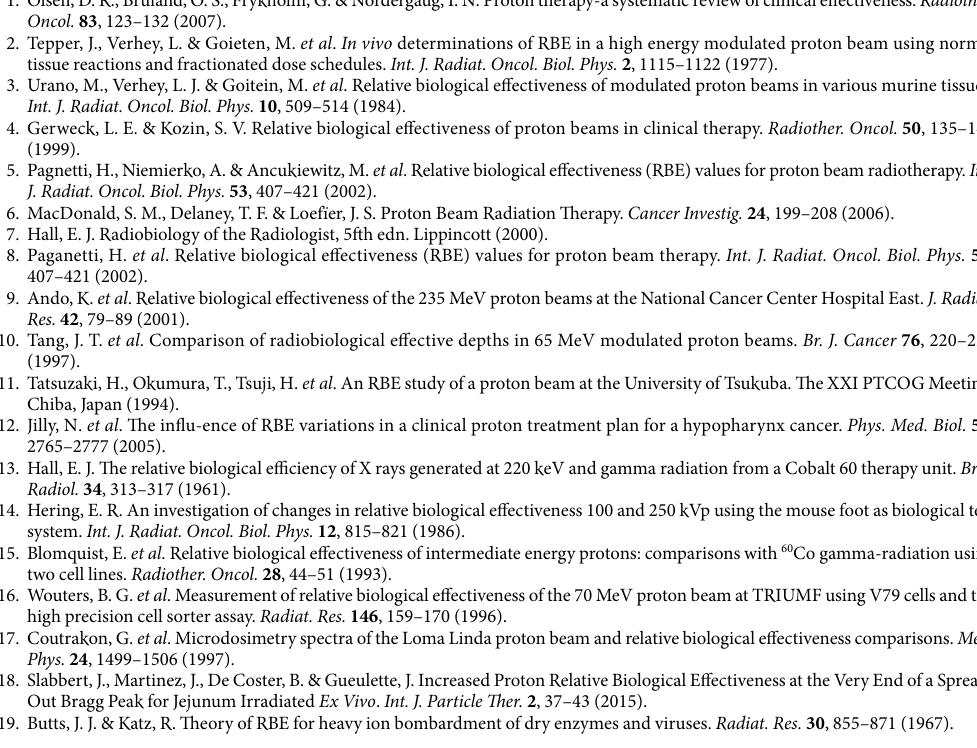
10 Scientific RepoRts | 7: 8340 | DOI:10.1038/s41598-017-08622-6